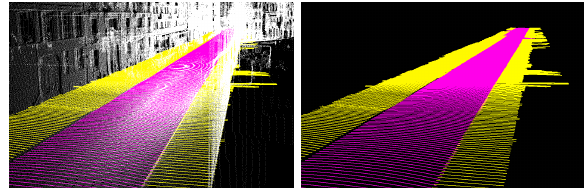
Figure 14: A reconstructed area, behind a vehicle. Point cloud is superimpose on the left.